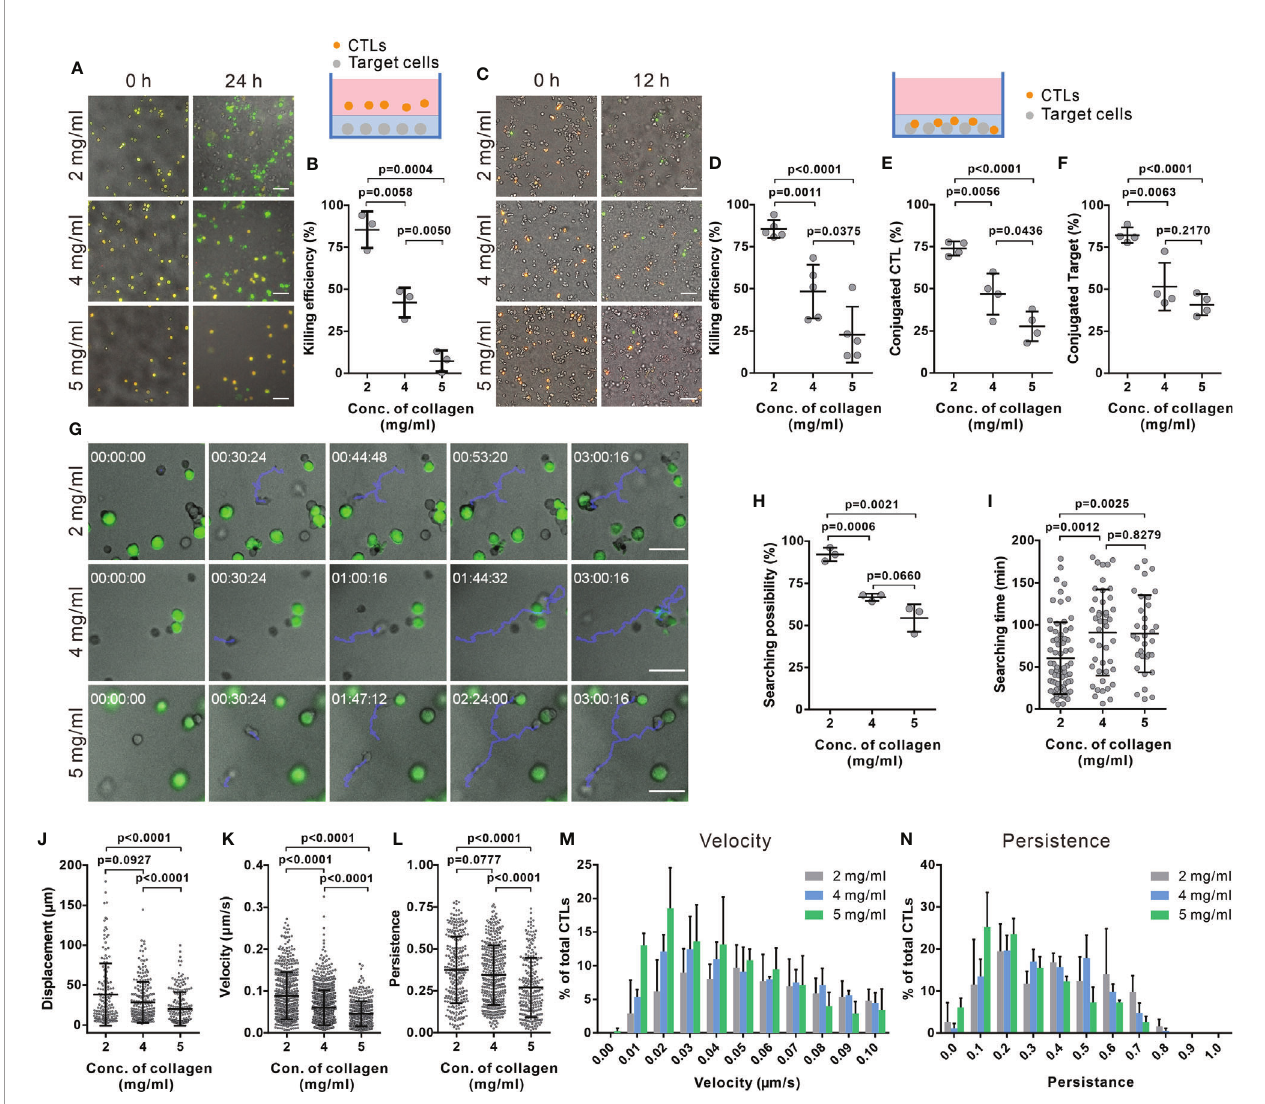
FIGURE 1 | The killing ef fi ciency of CTLs is substantially decreased in dense collagen matrices. (A, B) CTL killing ef fi ciency is impaired in dense collagen matrices. Target cells (SEA/SEB pulsed NALM-6-pCasper) were embedded in collagen in absence ( A, B, 3 donors, E (effector cells): T (Target cells) = 5:1) or presence of CTLs ( C, D, 5 donors, E:T=1:1). Images were acquired using ImageXpress with Spectra X LED illumination (Lumencor) for 24 hours (A, B) or 12 hours (C, D) . Orange and green color indicates live and apoptotic target cells, respectively. (E, F) Fraction of CTLs in conjugation with target cells (E) or target cells in conjugation with CTLs (F) was analyzed at 1 hour after polymerization (4 donors). (G – I) Searching ef fi ciency of CTLs is reduced in dense collagen. Target cells (SEA/SEB pulsed Raji) were loaded with calcein (green) and embedded in planar collagen with CTLs. Migration was visualized using Cell Observer (20× objective) at 37°C for 3 hours. Representative tracks are shown in (G) (blue lines). The likelihood to fi nd a target within 3 hours is shown in (H) (3 donors). Time required for CTLs to fi nd their fi rst target (if the cell found at least one target cell) is shown in (I) . (J – N) Characterization of CTL migration in collagen matrices. CTLs were transfected with histone 2B- GFP and LifeAct-mRuby, and then embedded in 3D collagen. Migration was visualized using light-sheet microscopy (20× objective) every 30 sec for 30 min. The nuclei positions were identi fi ed with Imaris to analyze displacement (J) , velocity (K) , and persistence of CTLs (L) (3 donors). The distribution of CTL velocity and persistence is shown in (M, N) , respectively. One dot represents either one donor (in B, D – F, H ) or one cell (in I – L ). Results are presented as Mean ± SD. The unpaired Student ’ s t-test was used for statistical signi fi cance, except (I – L) (the Mann-Whitney test was used). Scale bars are 50 m